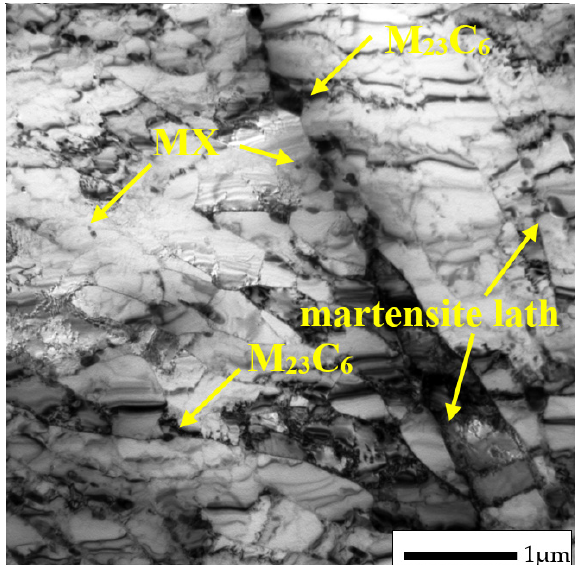
Figure 3. Microstructure of Thor 115 in initial condition by transmission electron microscopy (TEM).